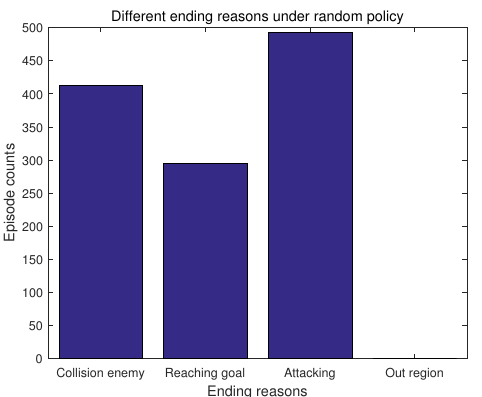
Figure 12. The total numbers of different ending reasons when using the random policy.